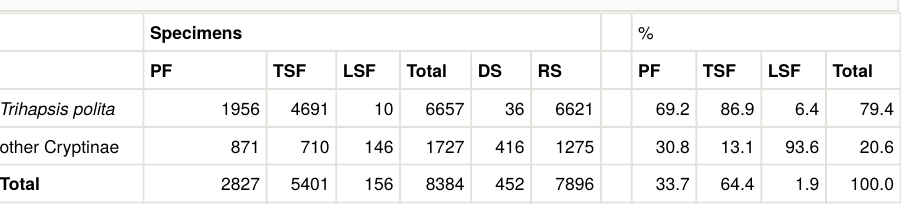
Total number of specimens collected for T. polita vs. other Cryptinae in all areas ( PF , primary forest; TSF , tall secondary forest; LSF , low secondary forest) and seasons ( DS , dry season; RS , rainy season). Sampling e ff ort was identical for all sampling areas, adding to 4,113 trap-days total, but di ff erent between seasons (DS=1,836,